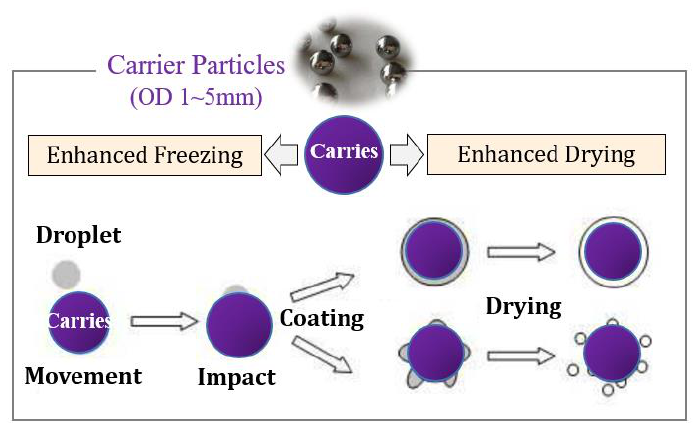
Figure 1. Schematic diagram of spray freeze-drying on fluidization particle surface.